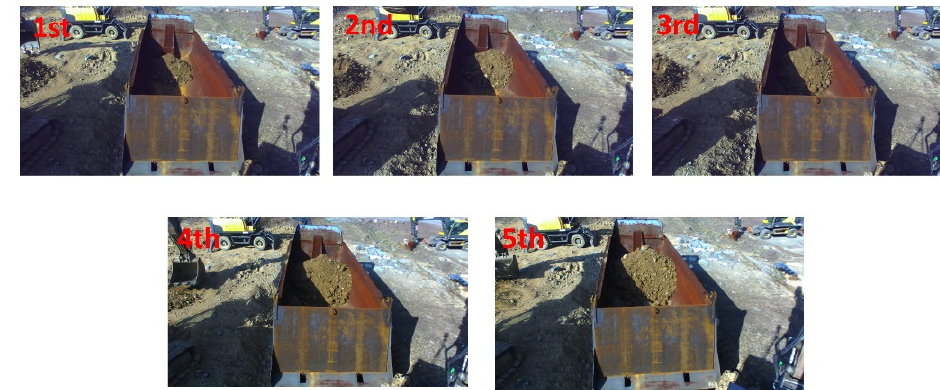
Figure 23. Volume estimations experiment of load.